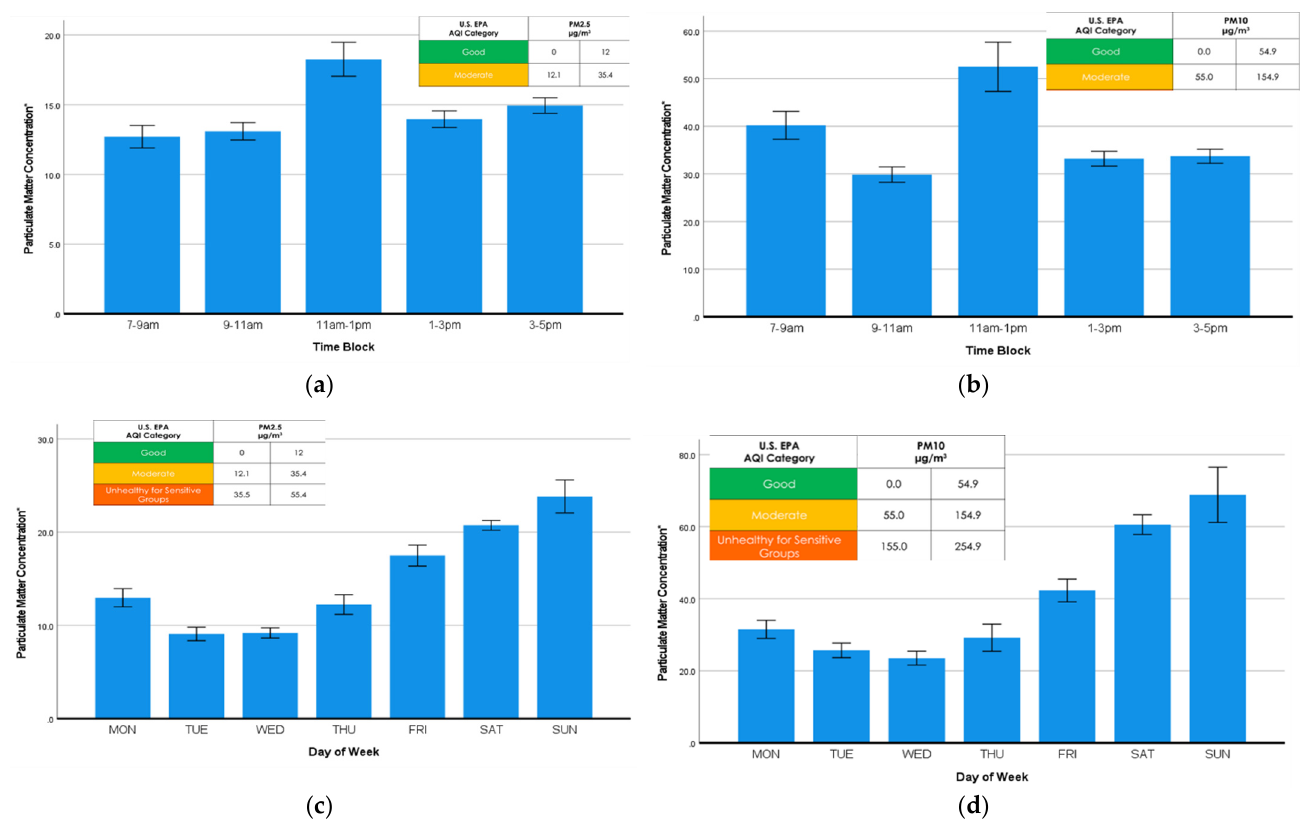
Figure 2. Temporal distribution of PM by time of day, week, and particle size: ( a ) boxplots of PM 2.5 by time block; ( b ) boxplots of PM 10 by time block; ( c ) boxplots of PM 2.5 by day of week; ( d ) boxplots of PM 10 by day of week. Note : Error bars represent 95% C.I. * Concentration in μ g/m 3 .